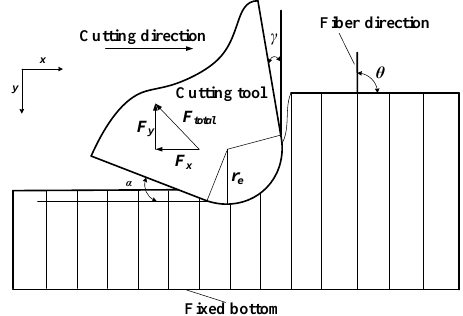
Figure 1. The schematic of fiber cutting angle.